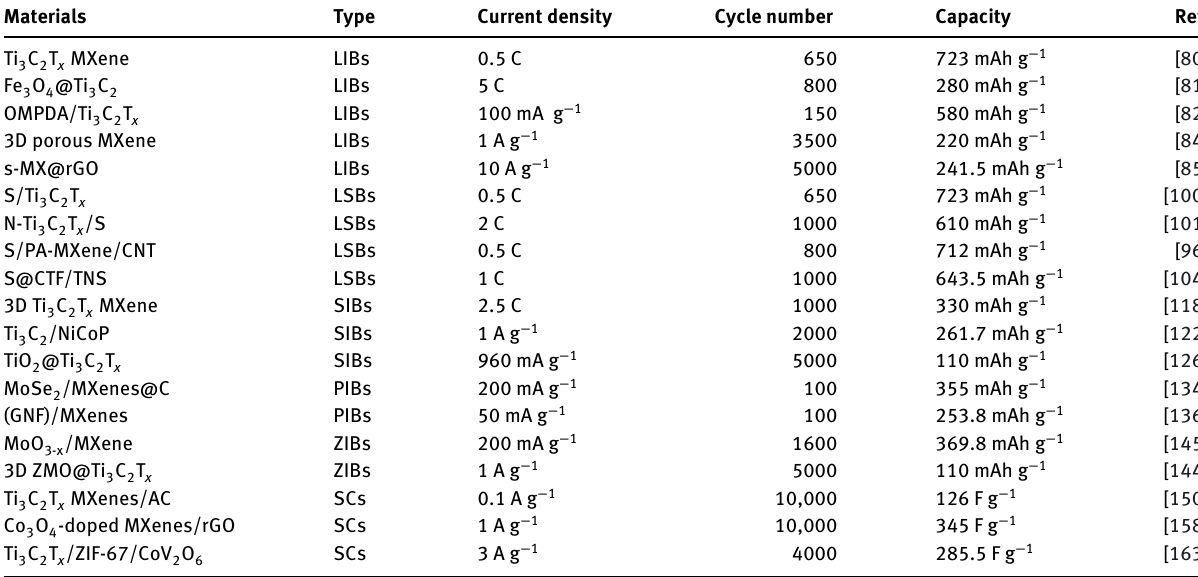
Table 2: The energy storage performances of different types of MXenes.